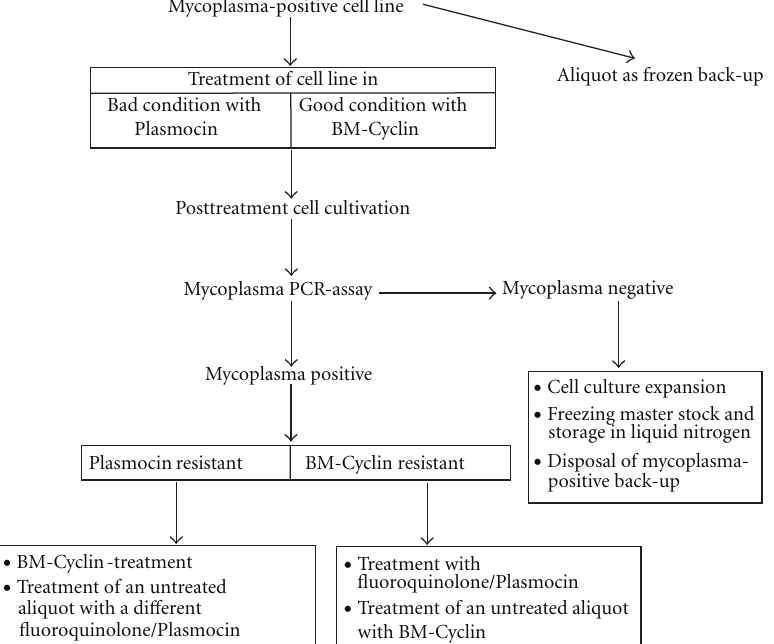
Figure 4: Approach to treatment of mycoplasma-positive cell cultures with specific antibiotics. The scheme was adapted from